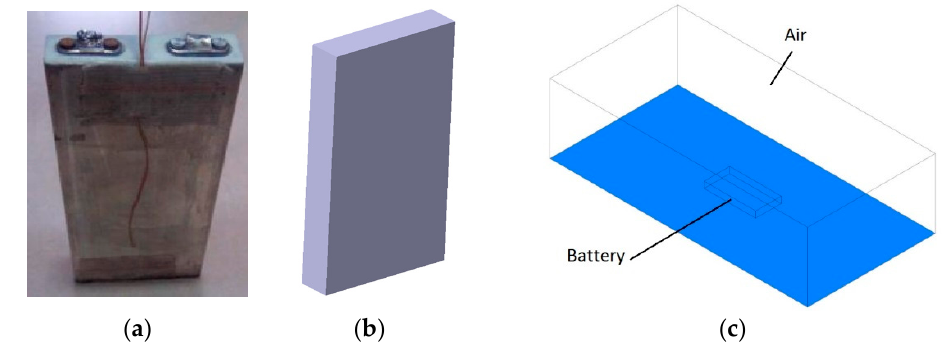
Figure 1. (a) Battery cell ； (a) cell geometry ； (b) heat transfer model. Figure 1. ( a ) Battery cell; ( b ) cell geometry; ( c ) heat transfer model.